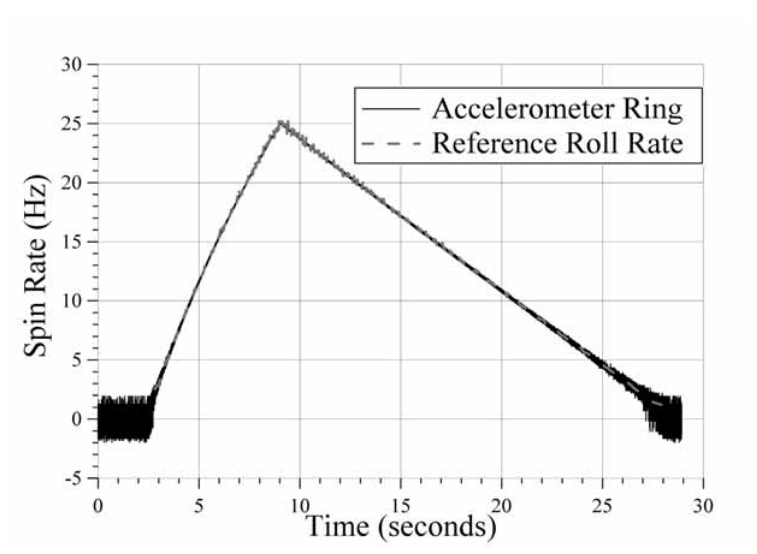
Fig. 8. Spin rate calibration vs.